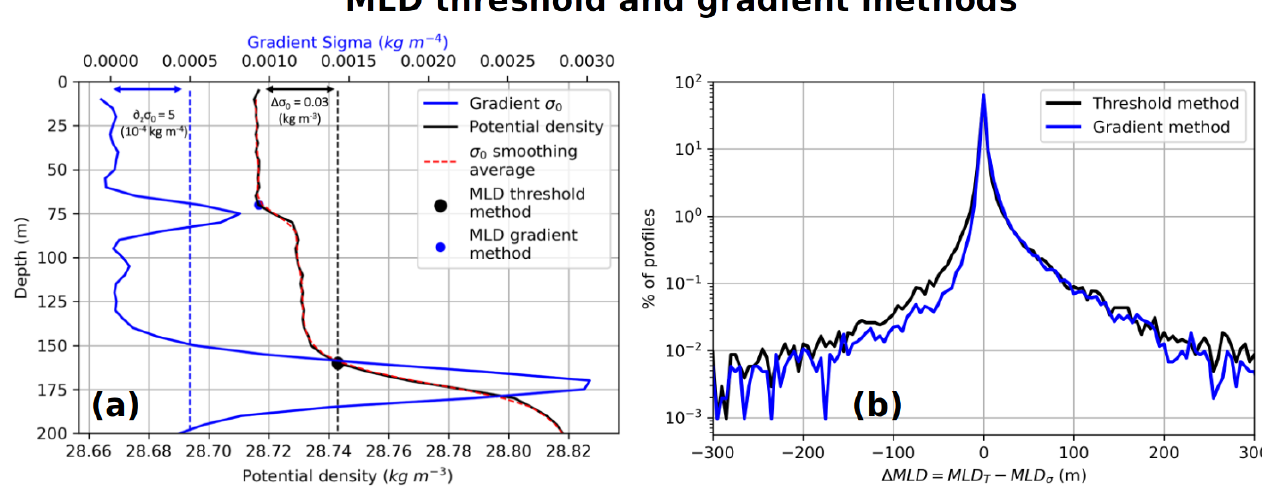
Figure 1. (a) MLD detection on one potential density profile with our gradient method (blue dot) and threshold method (black dot); (b) frac- tion of the profiles as a function of (cid:49) MLD for the threshold (black line) and gradient (blue line) method.